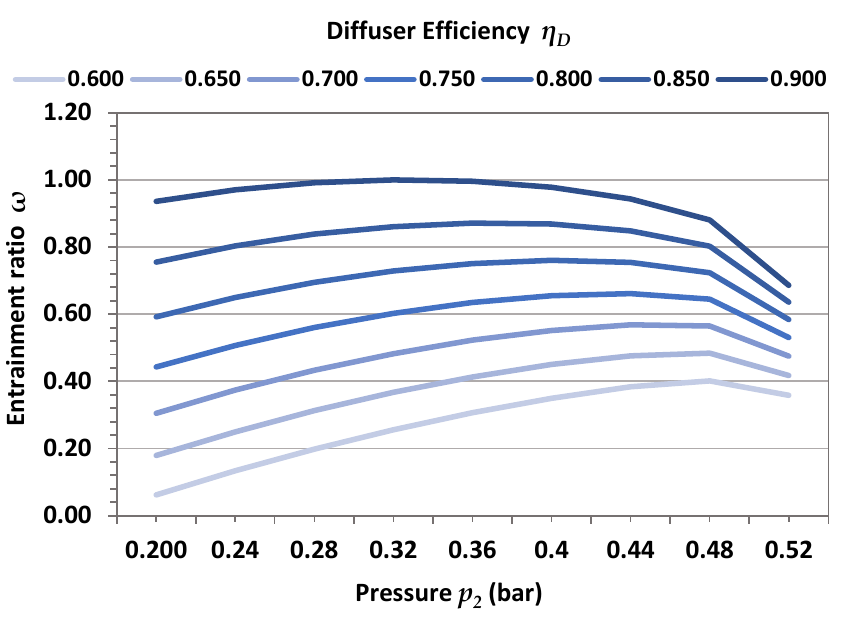
Figure 5. Function: ω = f ( p 2 ) parametric in η D .